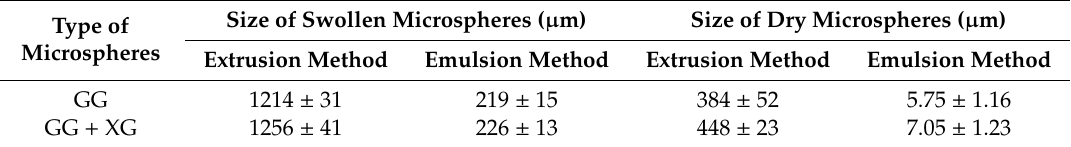
Table 2. Diameters of microspheres obtained by extrusion and emulsion